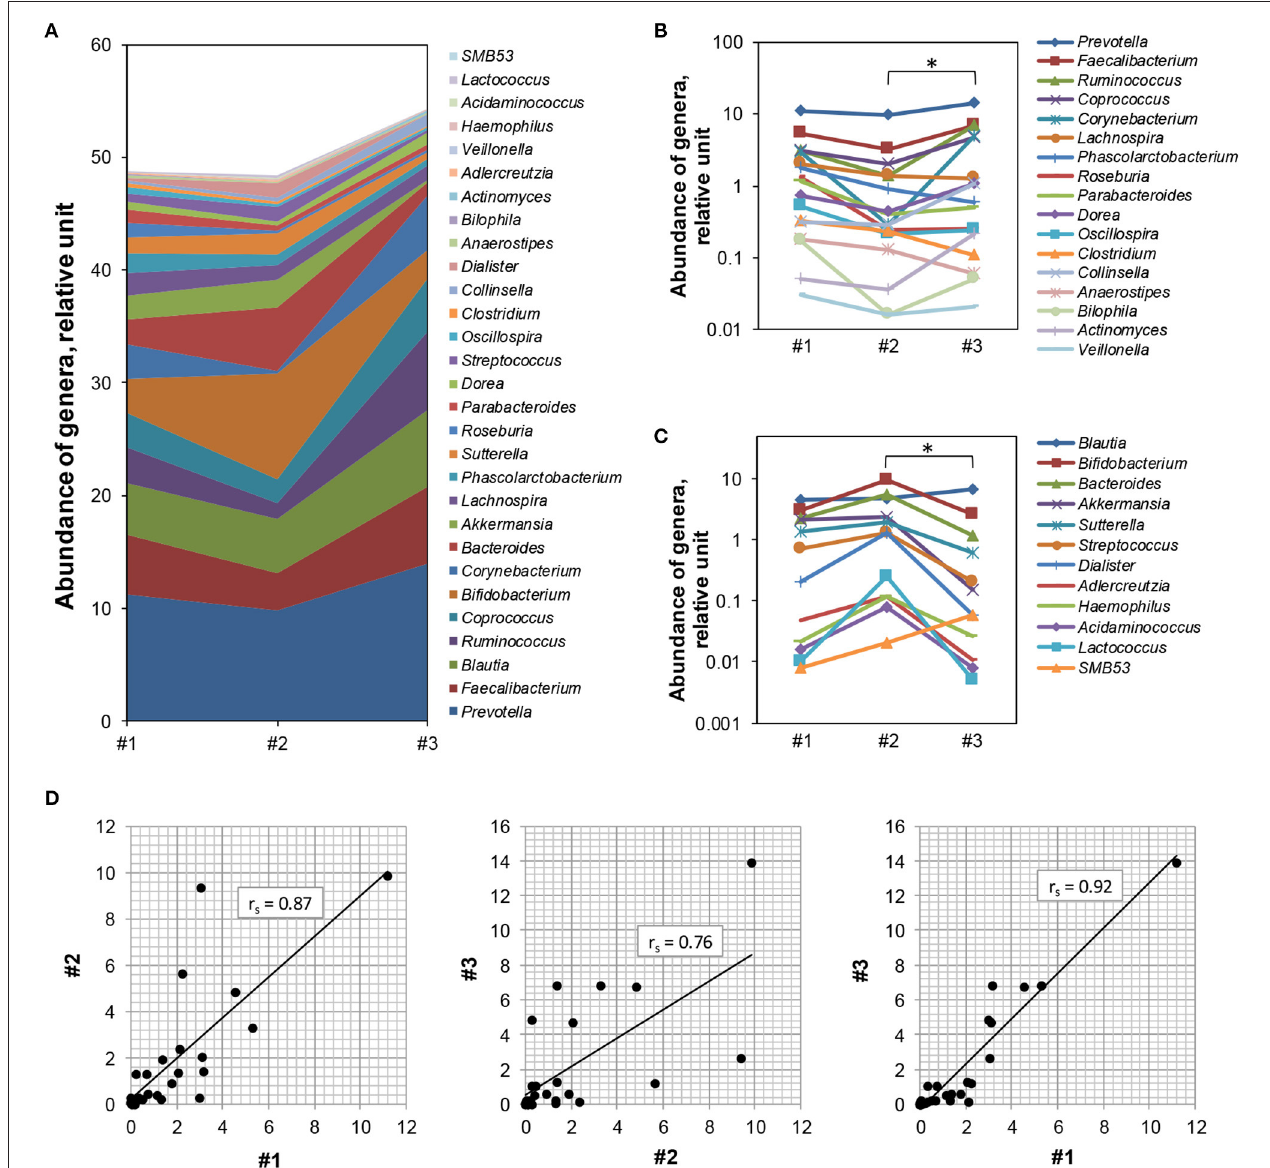
FIGURE 4 | Dynamic changes in bacterial genera composition during the study period. (A) The bacterial genera ( n = 29) detected in all three samples at different time points ( x -axis) are presented. y -axis—abundance of genera, in relative units. (B,C) Those species ( n = 17) predominantly producing acetate had higher abundance in sample #2 compared with sample #1 but were significantly lower in sample #3 (Wilcoxon rank sum test, p -value < 0.05, denoted by *) (B) , whereas, butyrate-producing species were higher in sample #3 and low in samples #1 and #2 (Wilcoxon rank sum test, p -value < 0.05, denoted by *) (C) . x -axis—serial time points; y -axis—abundance of genera, in relative units. The number of bacterial genera is plotted in logarithmic scale. (D) Correlations between the differential abundance of large bacterial genera ( n = 29) in the microbiome composition. The difference was high before vs. after the intake of fiber [sample #2 vs. #3, middle graph, Spearman’s correlation coefficient r s = 0.76 ( p < 0.0001)], as compared with that at the beginning and the end of the intense training period [sample #1 vs. #2, left graph, Spearman’s correlation coefficient r s = 0.87 ( p < 0.0001)], and also to that at the beginning and the end of the study [samples #1 and #3, Spearman’s correlation coefficient r s = 0.92 ( p < 0.0001)]. x - and y -axes—abundance of genera, in relative units. #1, time point week 1 (baseline); #2, time point week 27 (high training and competition period); #3, time point week 31 (after 30 days of dietary supplement